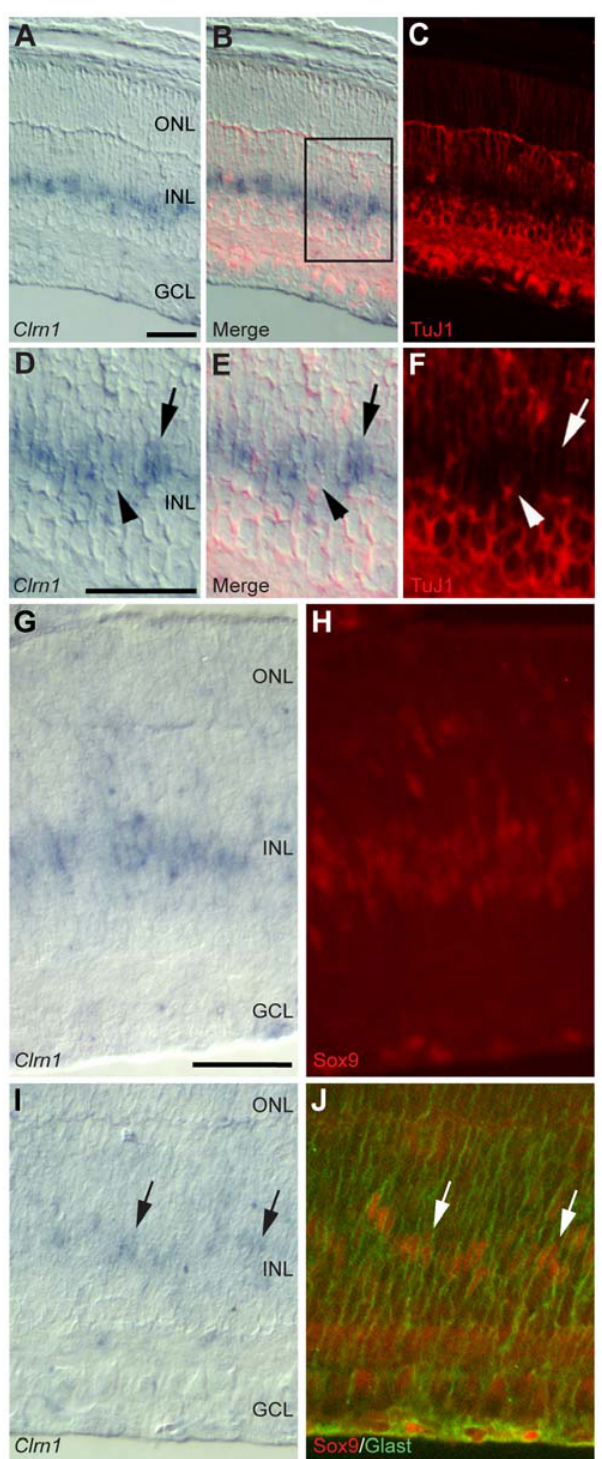
Figure 3. In situ hybridization and immunohistochemistry localize Clrn1 expression to Mu¨ller cells in P7 mouse retina. (A–C) A section of WT retina labeled for Clrn1 (A) and the neural marker TuJ1 (C). The merged images (B) show the lack of overlap with the neural specific marker. TuJ1 labels all inner retinal neurons, but not the Clrn1 -positive cells. (D–F) Higher magnification views of the boxed region in (B). Arrowhead points out a TuJ1-positive cell that is not Clrn1 - positive, while the arrow points to a cell that is Clrn1 -positive but not TuJ1-positive. (G,H) Peripheral retina labeled with the Clrn1